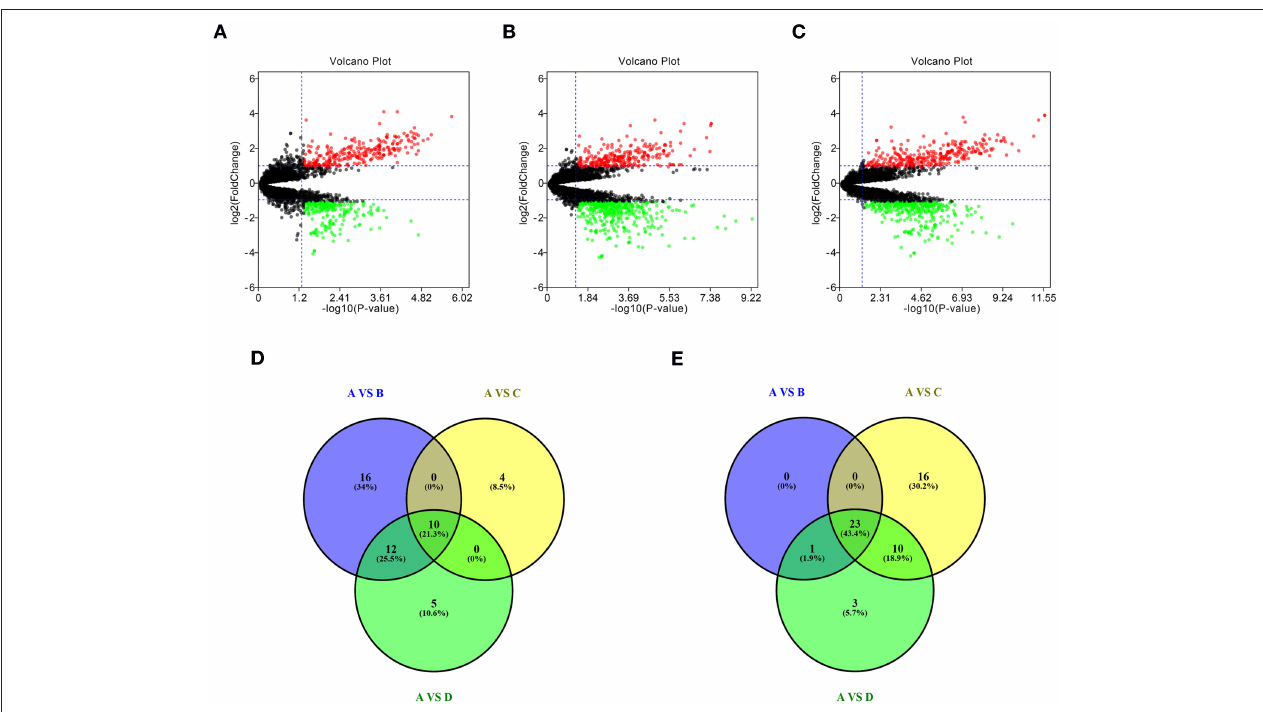
FIGURE 1 | Identification of differentially expressed miRNAs (DE-miRNAs). (A) DE-miRNAs between group A and group B; (B) DE-miRNAs between group A and group C; (C) DE-miRNAs between group A and group D; (D) intersection of upregulated DE-miRNAs in three compared sets; (E) intersection of downregulated DE-miRNAs in three compared sets. Group A contained GBM tumor tissue samples ( n = 16); group B contained adjacent normal brain tissue samples from GBM patients ( n = 4); group C contained normal brain tissue samples from healthy volunteer ( n = 3); group D contained normal samples from group B and C ( n = 7). |log 2 FC| > 2 and adj P < 0.05 were set as the thresholds for identifying DE-miRNAs. Red dots and green dots represent the upregulated and downregulated miRNAs in GBM tumor samples, respectively; black dots represent miRNAs that are not differentially expressed between tumor samples and normal